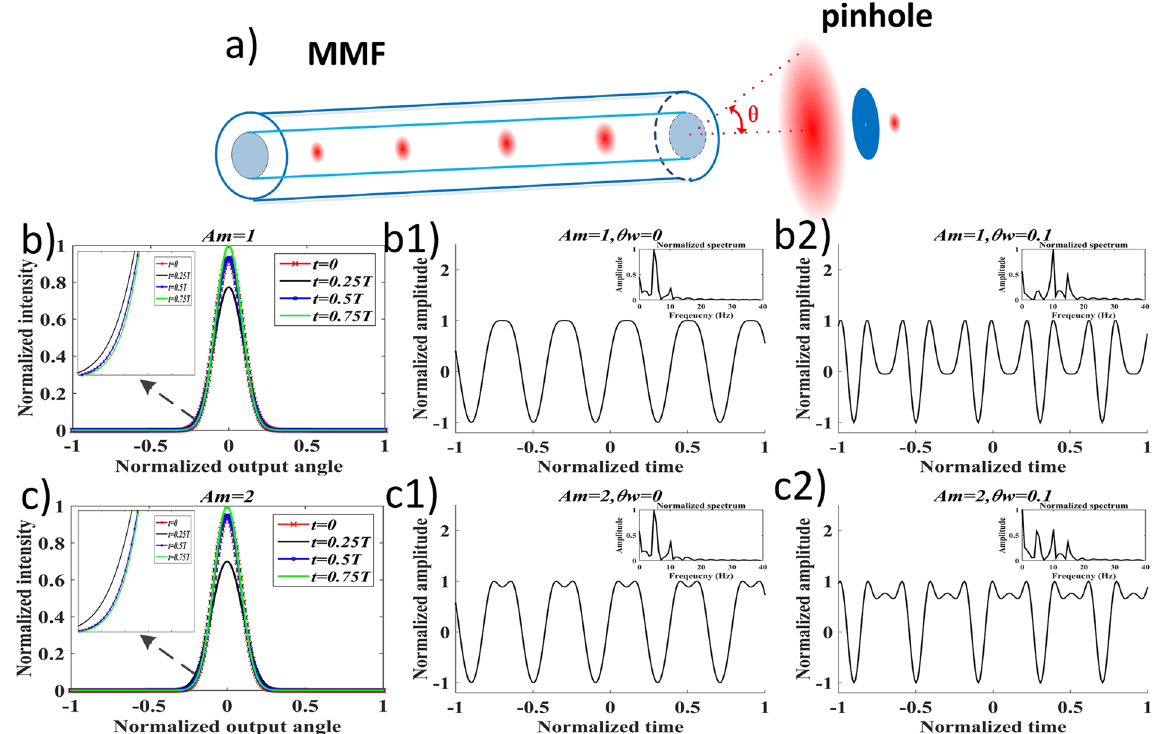
Figure 1. Numerical simulation results of the angular power flow distribution of a large core MMF under external perturbations. ( a ) shows the schematic illustration of power coupling within the MMF among different principal mode groups at different propagation angles. External perturbations can tune the mode coupling and hence the power flow. The power flow that passes through a pinhole can manifest the perturbation signal pattern. ( b and c ) show the angular intensity profiles from MMF when the coupling coefficient in Equation (1) was D = D 0 (1 + A m sin(2 π t / T )) 2 , where T was the period of external perturbation, D 0 was the static coupling coefficient and A m was the modulation amplitude of induced coupling coefficient by the perturbation. A selecting window (pinhole) of size 0.01 (normalized unit) that only allowed part of light to be detected was placed with its center θ w at 0 and 0.1, which gave rise to the signal patterns ( b1 ) and ( b2 ) for A m = 1 and signal patterns ( c1 and c2 ) for A m = 2. The insets in ( b and c ) illustrate that stronger mode coupling lead to optical power flow from smaller angle modes into larger angle modes. However, the total power was conserved since there was only power exchange among the guided modes, i.e. the areas under different intensity profiles in ( b and c ) are same. The insets in ( b1 , b2 , c1 and c2 ) are the frequency spectra corresponding to the temporal